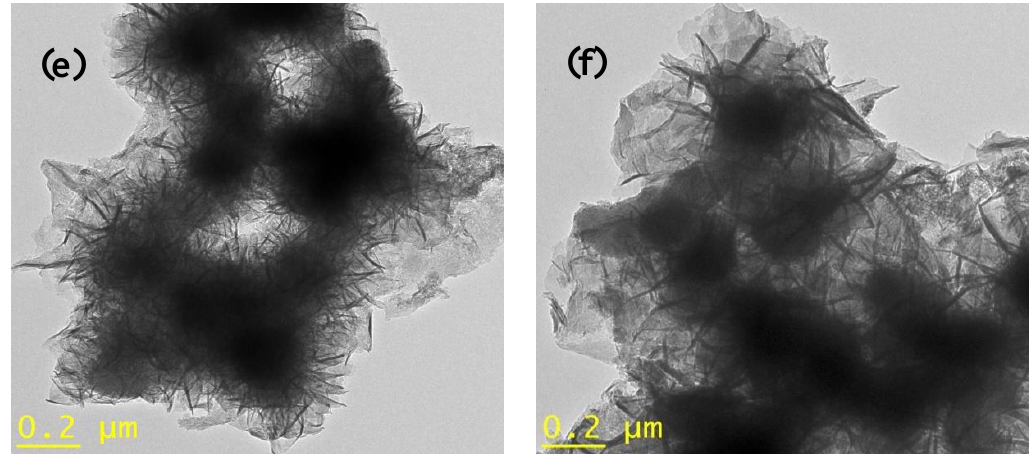
Figure 5. TEM images of zeolite ( a ), FeZ-1.5 ( b ), FeZ-3 ( c ), FeZ-5 ( d ), FeZ-8 ( e ), and FeZ-10 ( f ) composites.